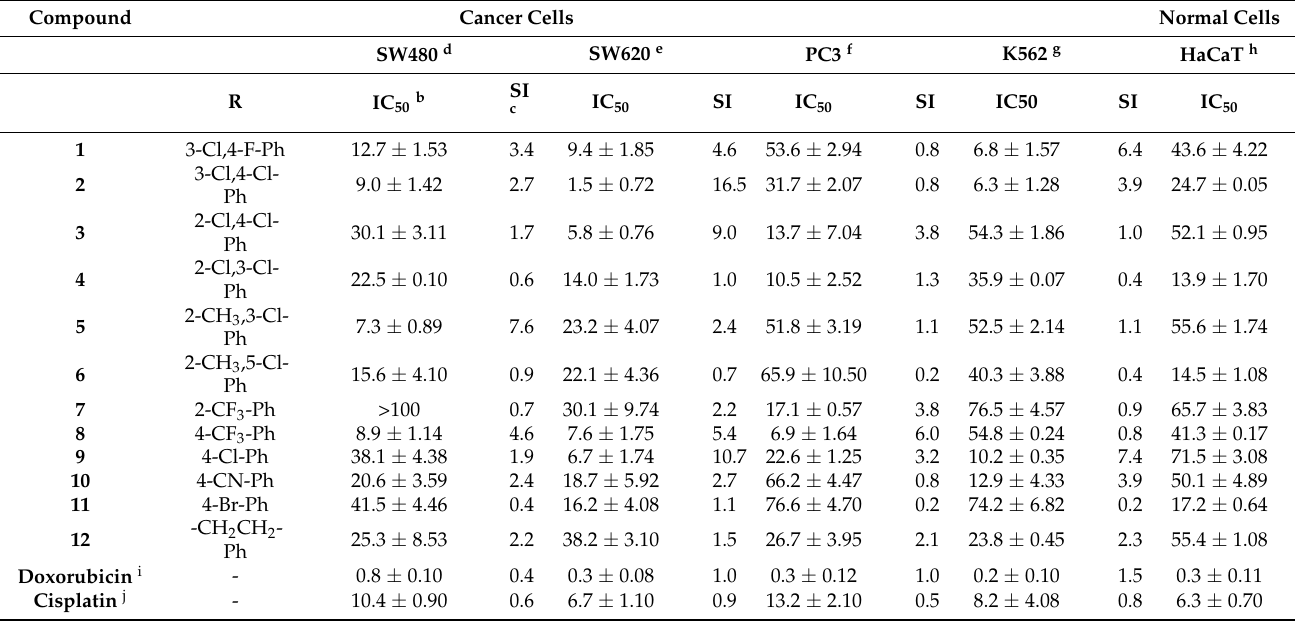
Table 1. Cytotoxic activity (IC 50 , µ M) of hte studied compounds estimated by the MTT assay a .